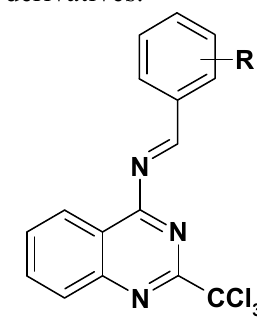
Figure 1. Novel investigated